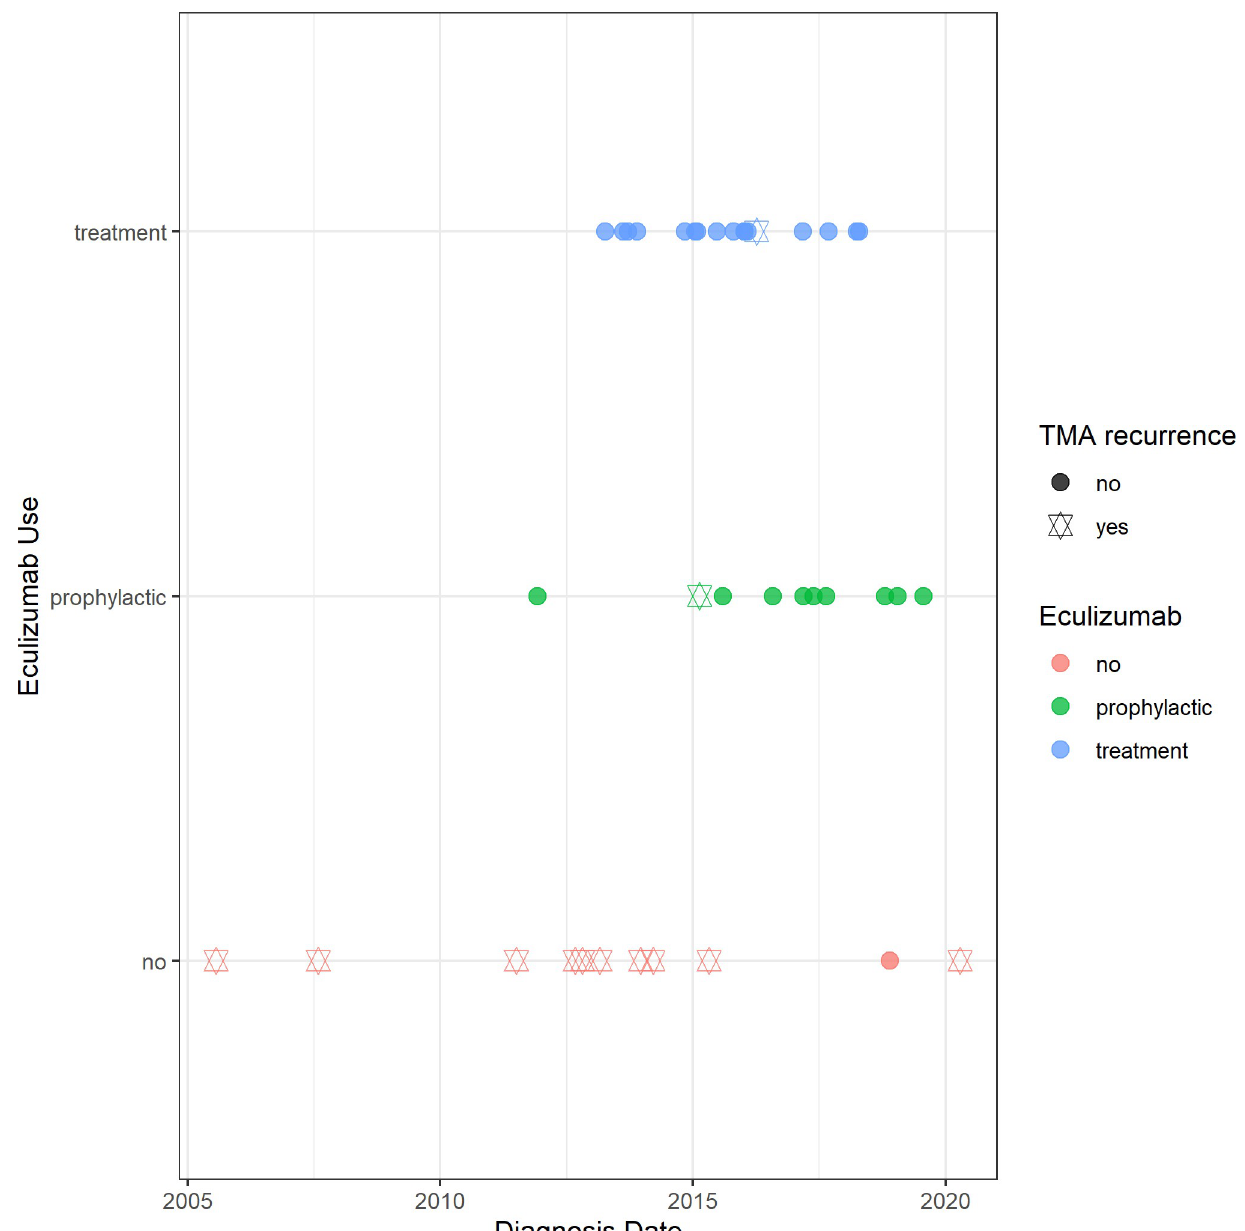
Fig 4. Outcomes of the Brazilian aHUS cohort patients divided by year of the aHUS diagnosis. Colors: not received eculizumab (red), prophylactic eculizumab (green) and eculizumab treatment (blue).